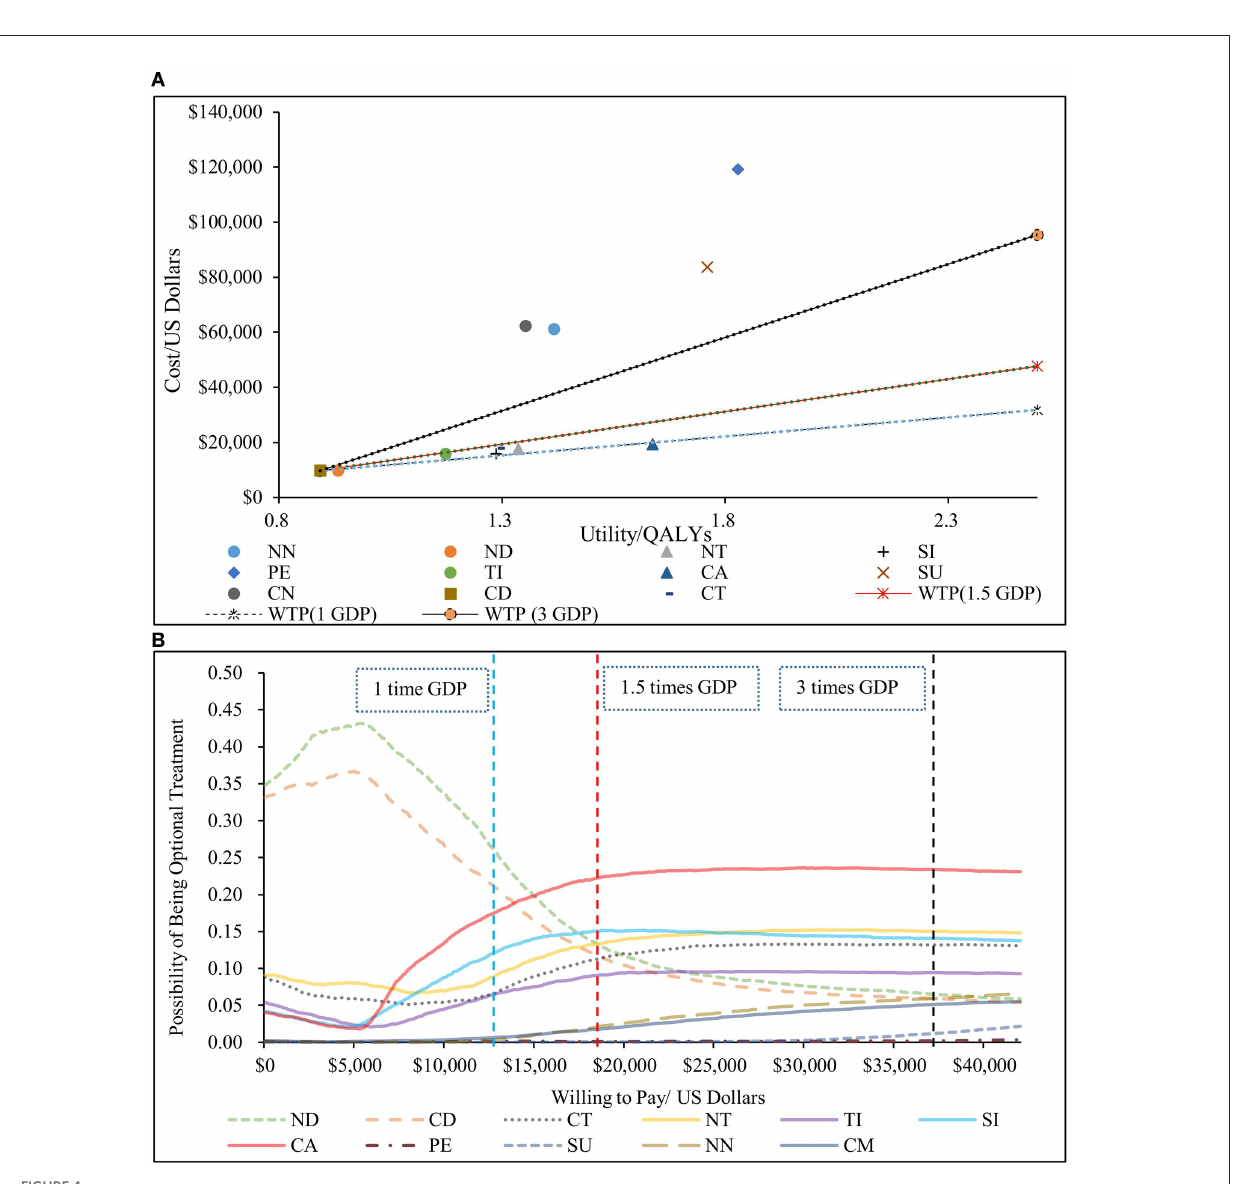
Hao et al. (60) showed that nivolumab combined with ipimumab was not cost-effective compared with chemotherapy in advanced EGFR or ALK mutation-negative NSCLC. Wu et al. (61)